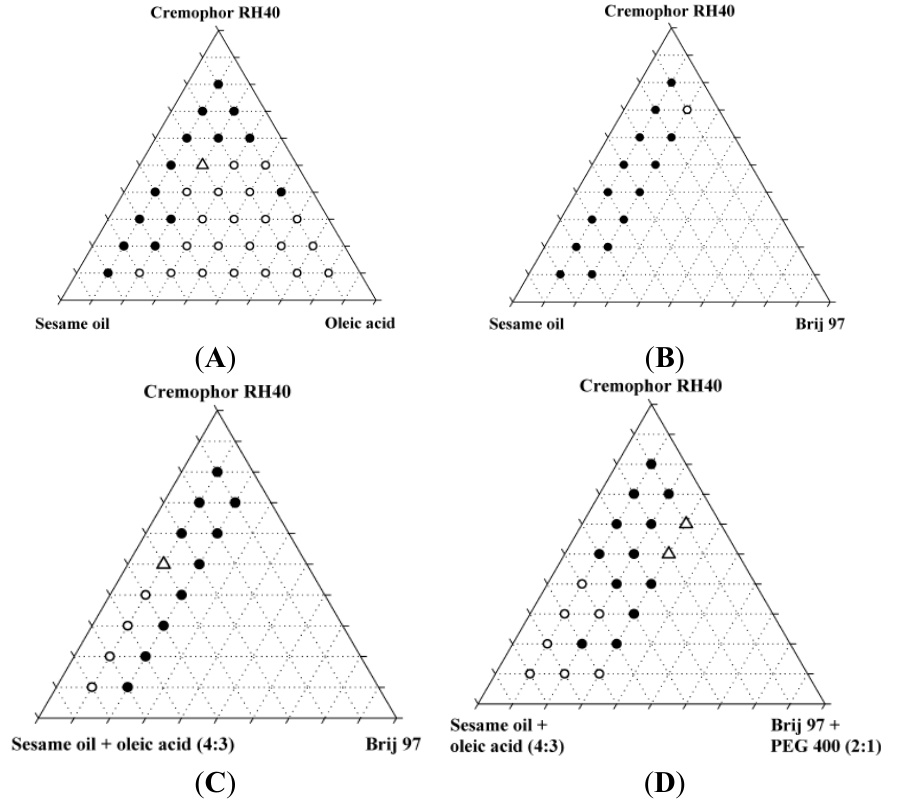
Figure 2. Miscibility of SNEDDS excipients depicted in pseudo-ternary diagrams. Additionally, these mixtures all contained 10% w / w ethanol. Solid circles are inhomogeneous mixtures, open circles are homogeneous mixtures, open triangles are homogeneous mixtures that forms nanoemulsions in water at a concentration of 1% ( w / w